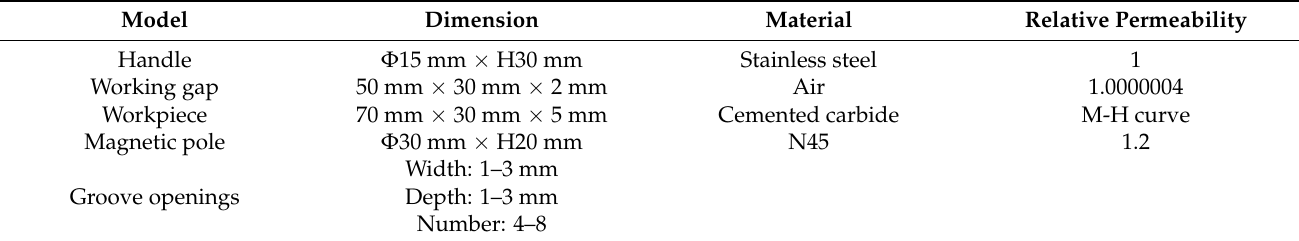
Table 1. Material and geometry of the model.